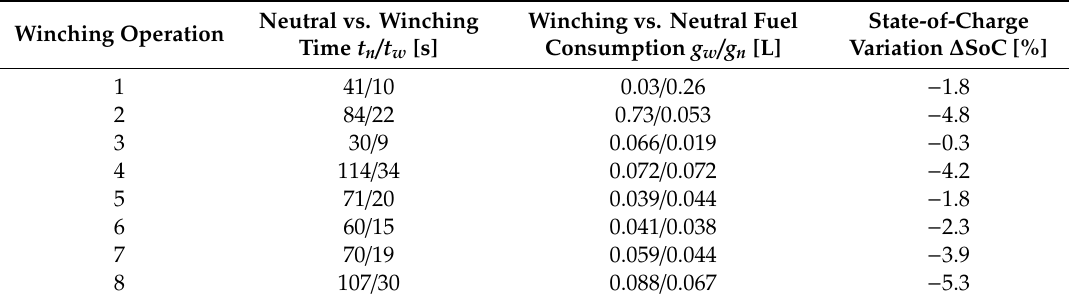
Table 9. Winching operations and their characteristics.